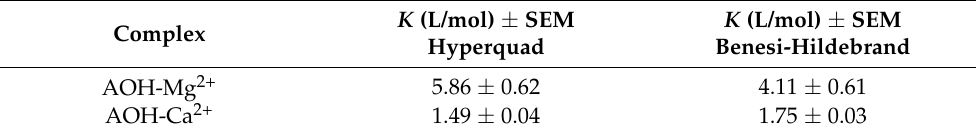
Table 1. Binding constants ( K ) of AOH-cation complexes in Tris-HCl buffer (50 mM, pH 7.0).